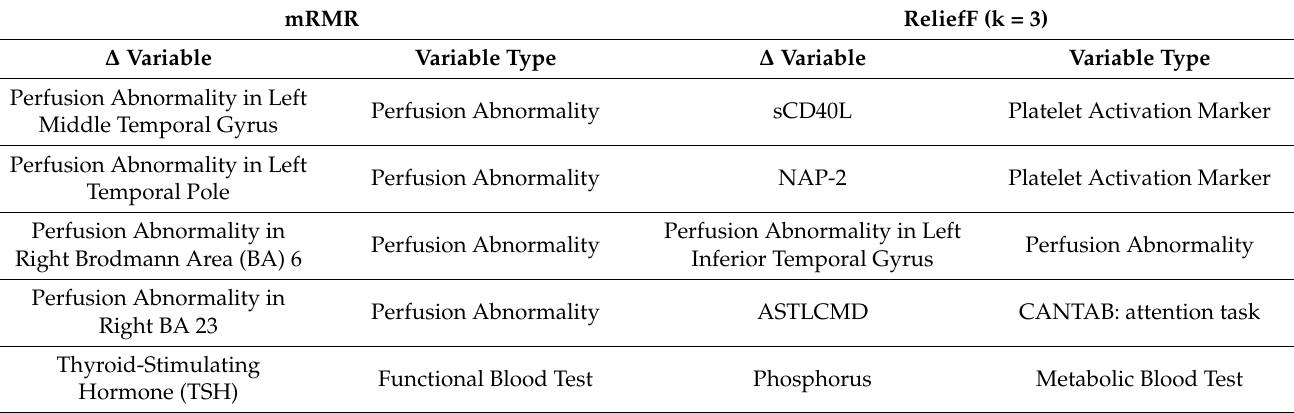
Table 4. Five most distinct placebo vs. rosuvastatin non-behavioral features selected by the two feature selection techniques. mRMR ReliefF (k = 3) ∆